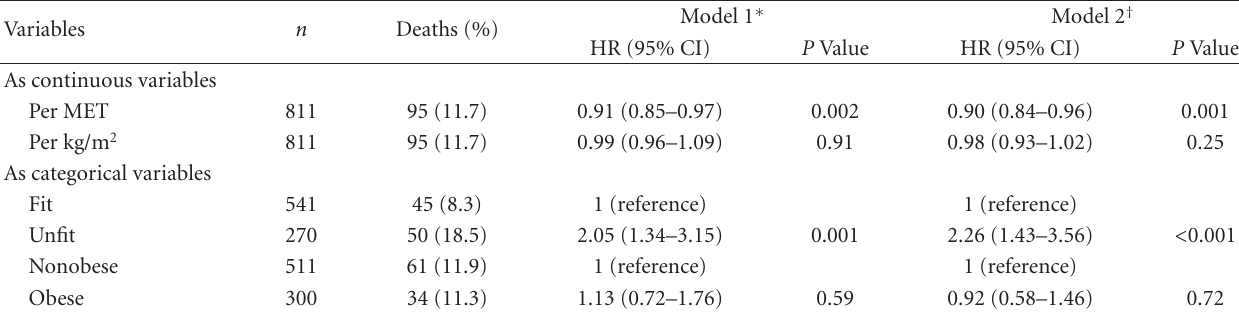
Table 2: Independent associations of baseline fitness and BMI with all-cause mortality.